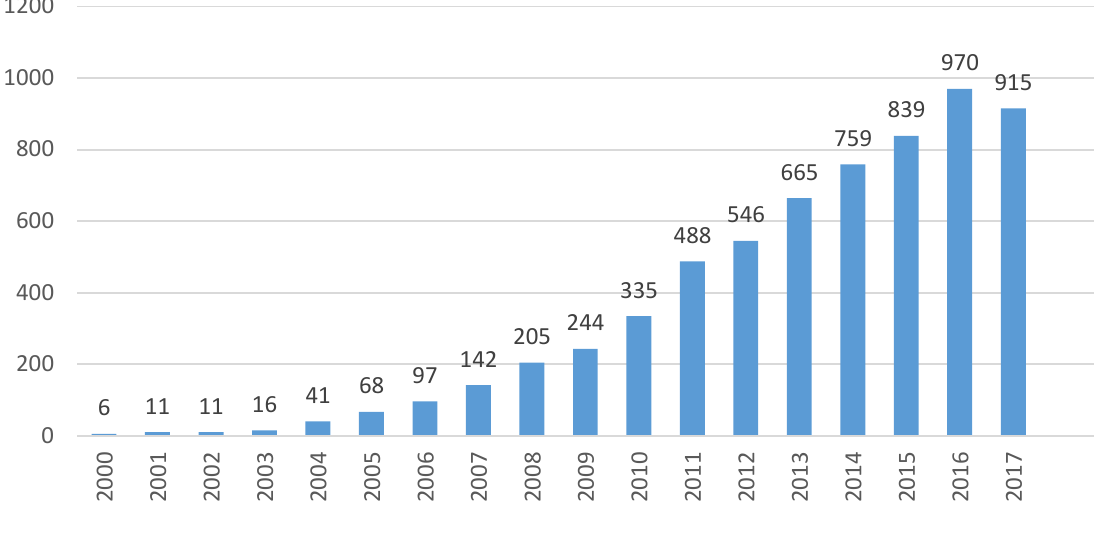
Figure 1. The number of reports on the sustainable Table 3. The number of reports on sustainable development submitted by financial sector